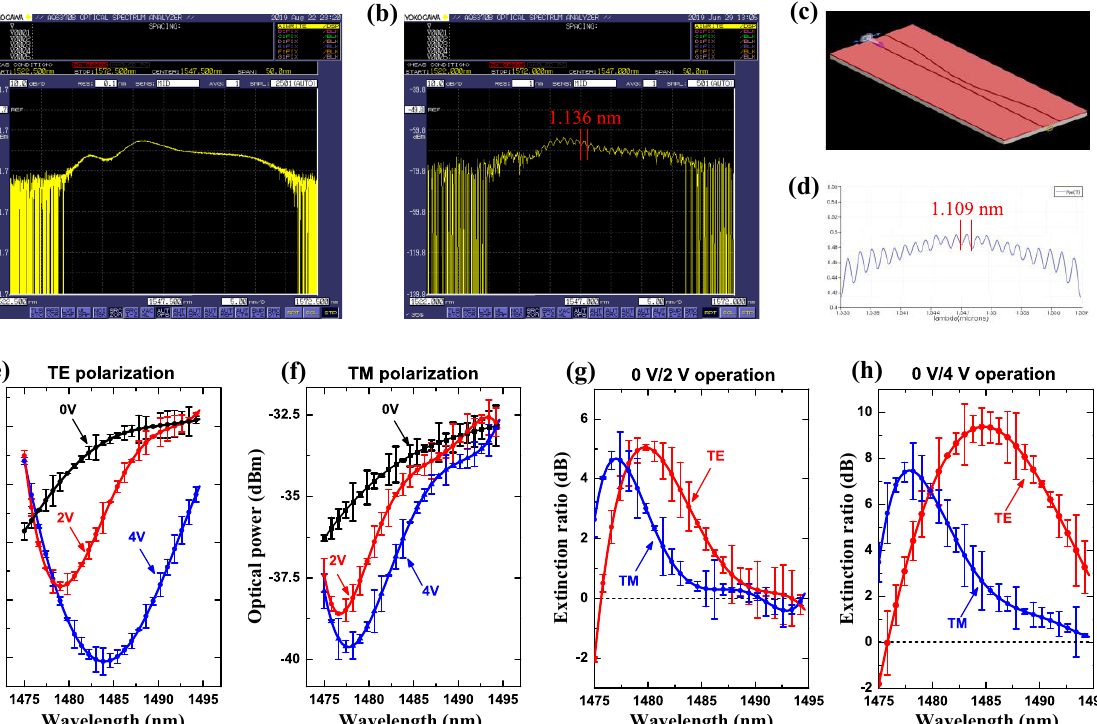
Figure 5: (a) Photograph of the stage. (b) Microscope image of the fabricated device with two lensed fibers,top view.(c) Oblique view.